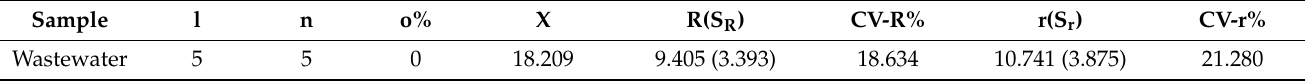
Table 8. Summary of interlaboratory test results from the Lemna wastewater test.